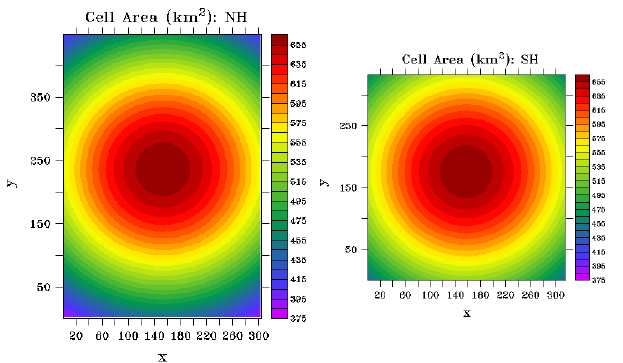
Figure 1. Distribution of cell areas (km 2 ) of the NSIDC polar stere- ographic grid for the Northern (left) and Southern Hemisphere grid (right).